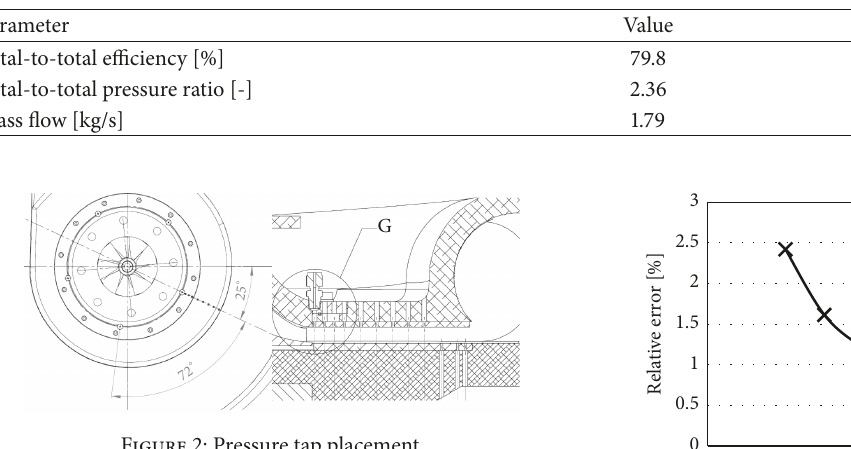
Figure 2: Pressure tap placement.